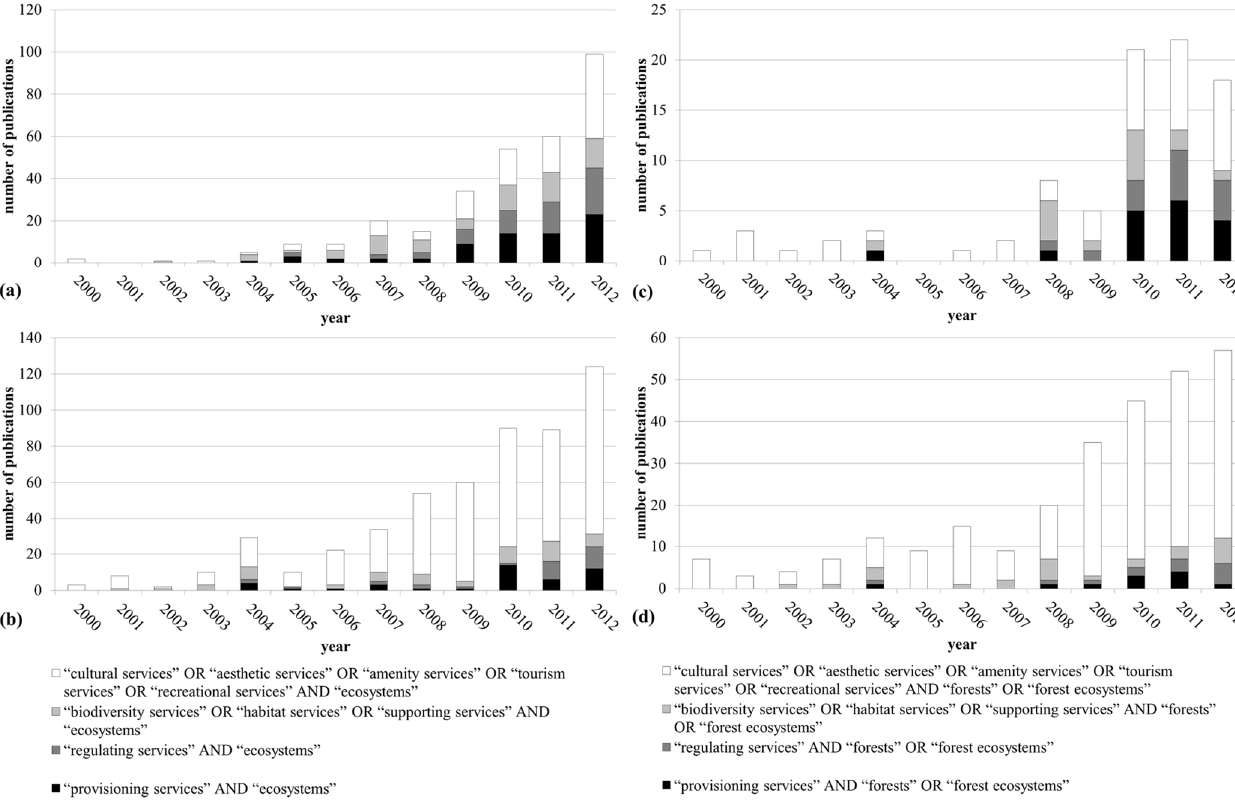
Figure 2. Trends of the number of publications per year for Review Sections 2 ( a , b ) and 3 ( c , d ), and for SCOPUS ( a , c ) and ISI-Web of Science ( b , d